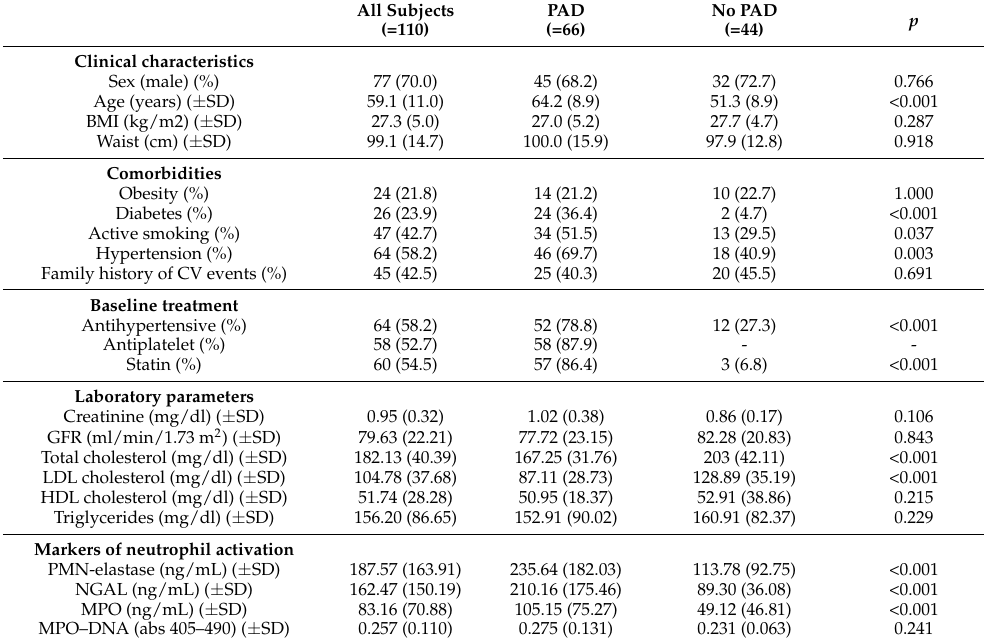
BMI: body mass index; CV: cardiovascular disease; HDL: high-density lipoprotein; GFR: glomerular filtration rate; LDL: low-density lipoprotein; MPO: myeloperoxidase; NGAL: neutrophil gelatinase-associated lipocalin; PAD: peripheral artery disease; PMN: polymorphonuclear neutrophil; SD: standard